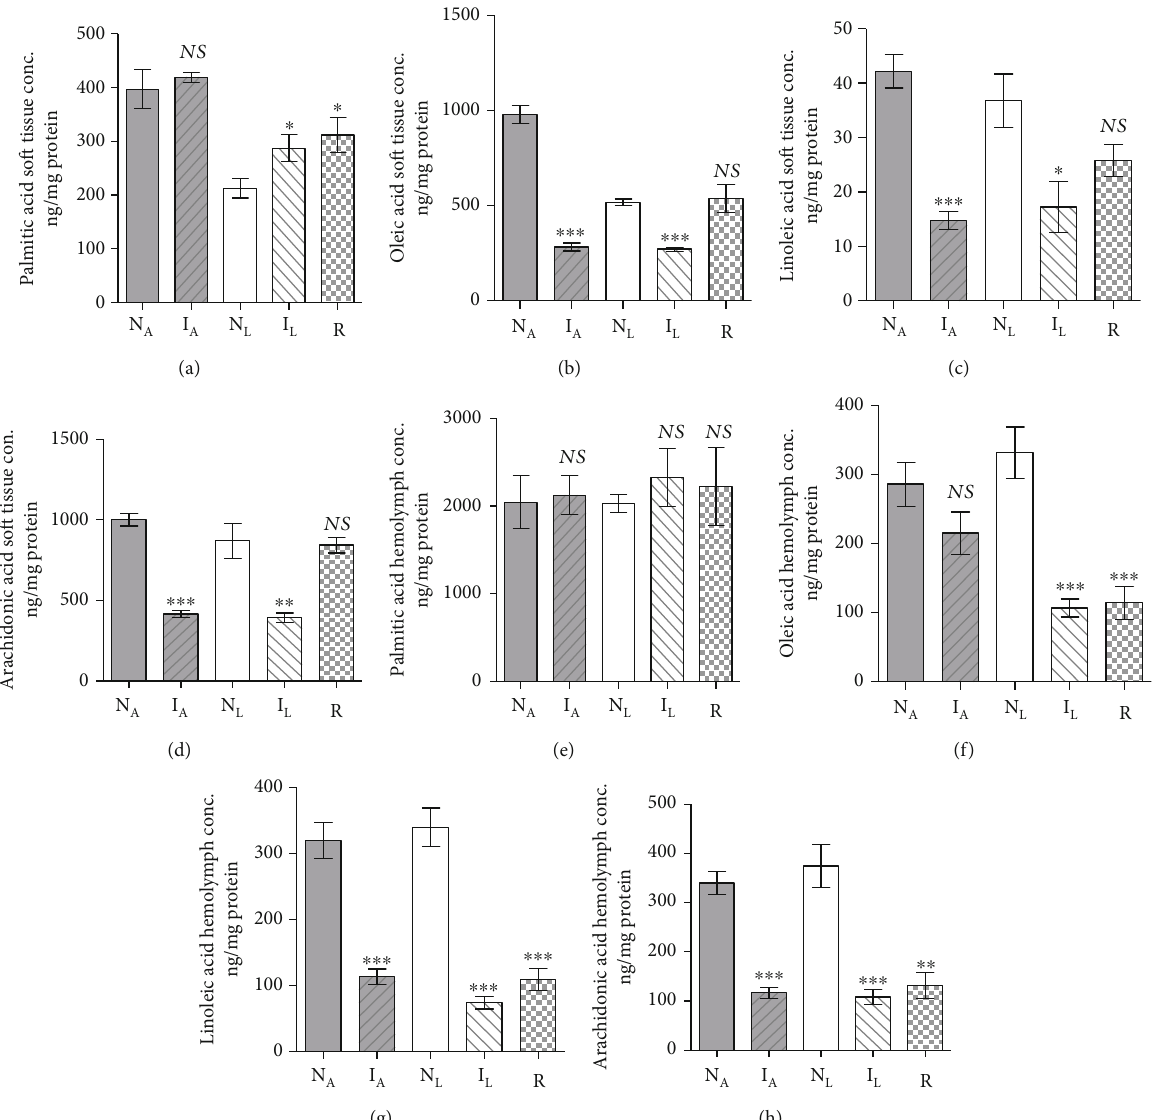
Figure 2: Each column represents mean B. alexandrina soft tissue and hemolymph fatty acid level content. Each column represents mean soft tissue palmitic (a), oleic (b), linoleic (c), and arachidonic (d) acid and hemolymph palmitic (e), oleic (f), linoleic (g), and arachidonic (h) acid content for fi ve B. truncatus snails, and vertical bars the SE about the mean. N infected-lettuce fed; R: resistant snails, and vertical bars the SE about the mean. Statistical di ff erences between naïve and susceptible or resistant same diet-fed snails are shown; ∗∗ 0 : 001 < P < 0 : 005 ; ∗∗∗ P < 0 : 001 . NS: not signi fi